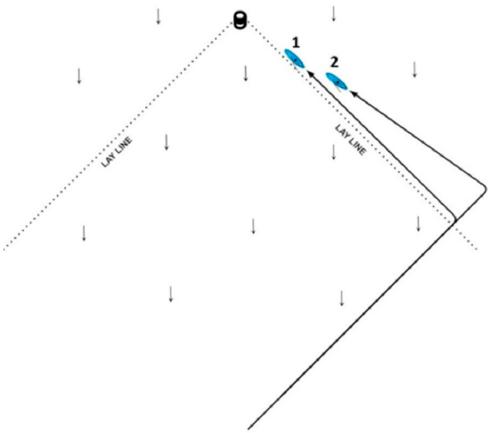
Figure 2. Examples of variants of windsurfing board courses, depending on the moment of the last tack. 1—windsurfer took the optimal course thanks to a sound message (“Layline”); 2—windsurfer overstepped layline.